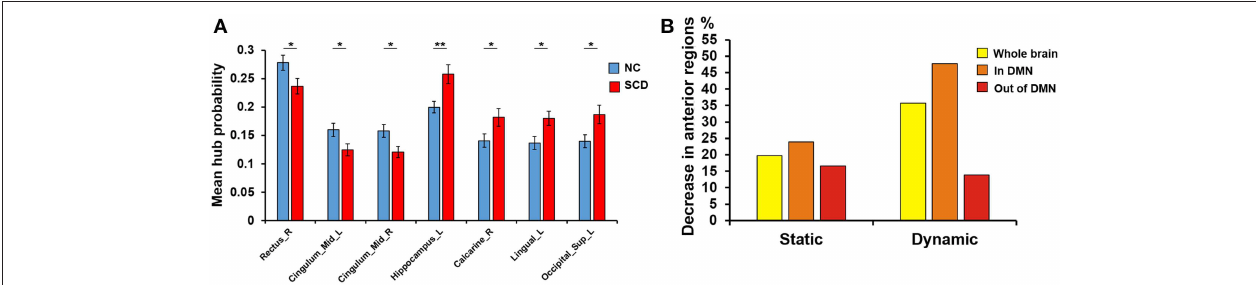
FIGURE 1 | Difference between groups at the absolute threshold (correlation efficient r = 0.25). (A) The mean hub probability of seven brain regions (right gyrus rectus, left midcingulate area, right midcingulate area, left hippocampus, right calcarine sulcus, left lingual gyrus and left superior occipital) showed significant difference between NC (blue) and SCD (red) group. Statistical significance: * p < 0.05; ** p < 0.01. (B) The proportion of anterior regions in NC group minus the proportion in SCD group from the three levels: whole brain (yellow), in DMN (orange) and out of DMN (red). Both the static and dynamic functional connectivity results were shown.